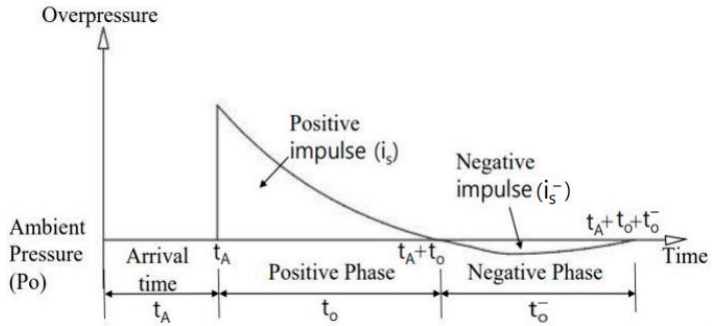
Figure 3. Pressure and time relation at the free air blast wave.